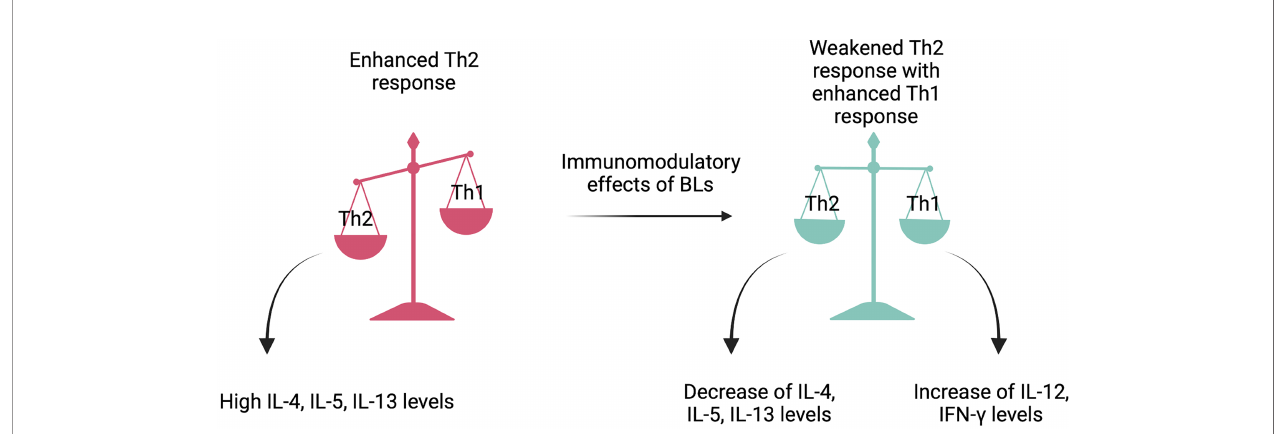
FIGURE 2 | The Th1/Th2 balance restoration. Bacterial lysates act like immunomodulators and provide the maintenance of violated Th1/Th2 balance. By stimulating dendritic cells, they activate the production of numerous cytokines that weaken Th2 type response and enhance Th1 type response. The said restoration leads to allergy symptoms amelioration. Created with